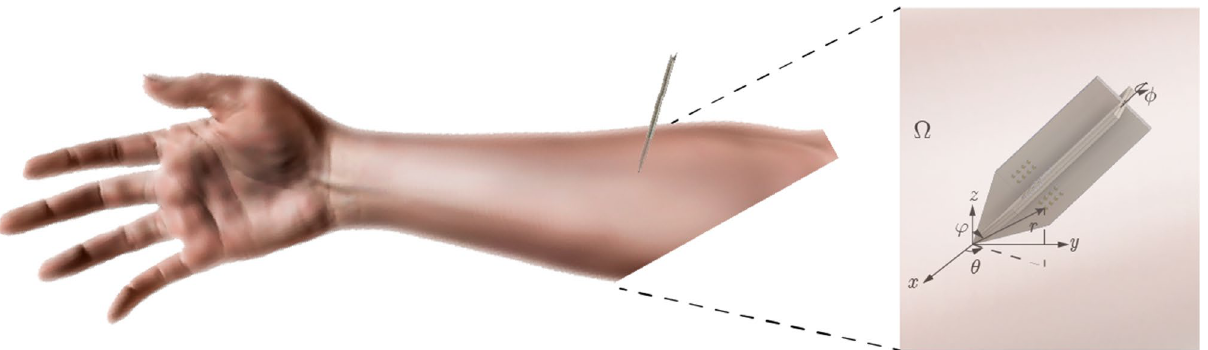
Figure 2. Insertion of the needle to the skeletal muscle and inlet representing a model abstraction of an arbitrary geometrical arrangement of muscle domain (cid:31) and needle to illustrate the spherical coordinate system